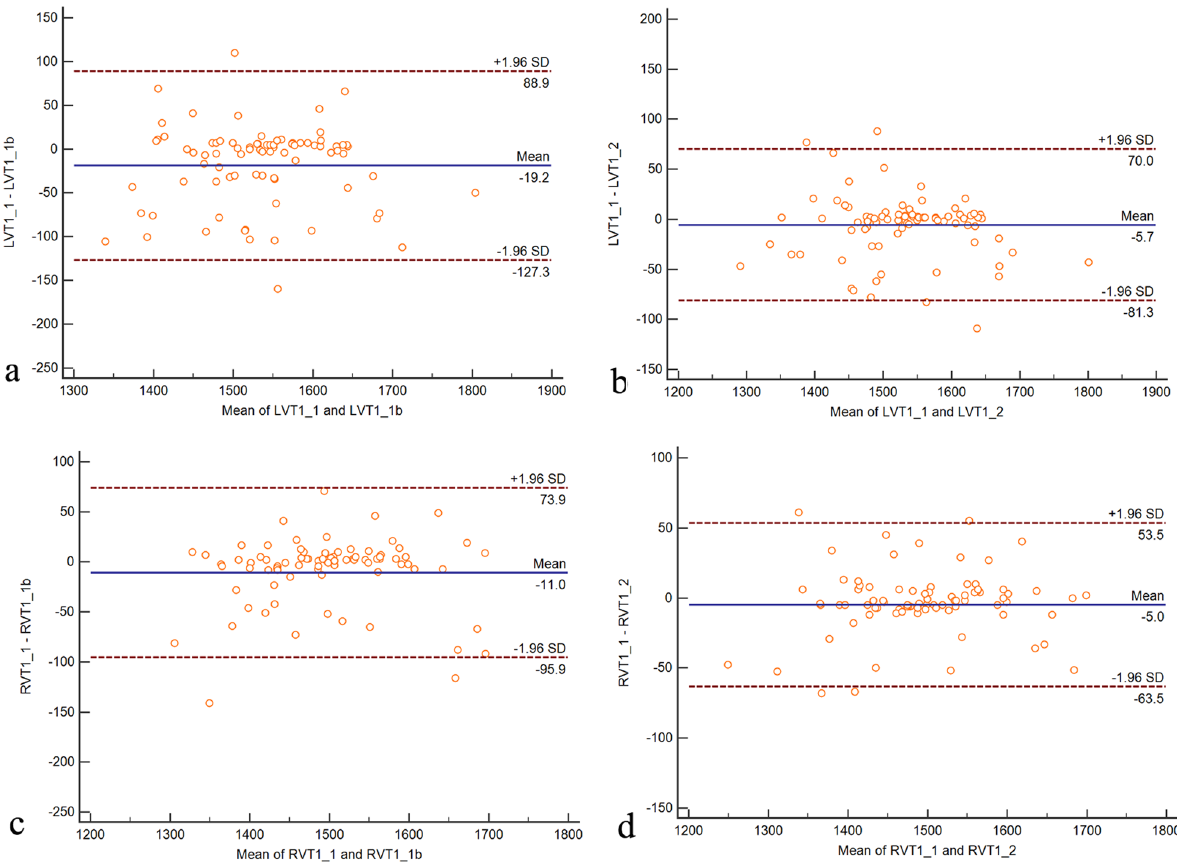
Fig. 2 A Bland–Altman plot of left ventricular blood pool T1 (LVT1) and right ventricular blood pool T1(RVT1)measurements. a The intra-observer mean difference for LVT1 was 19.2 (95% confidence interval [CI] − CI 81.3 to 70.0). c The intra-observer mean difference for RVT1 was − was 5.0 (95% CI 63.6 to − −